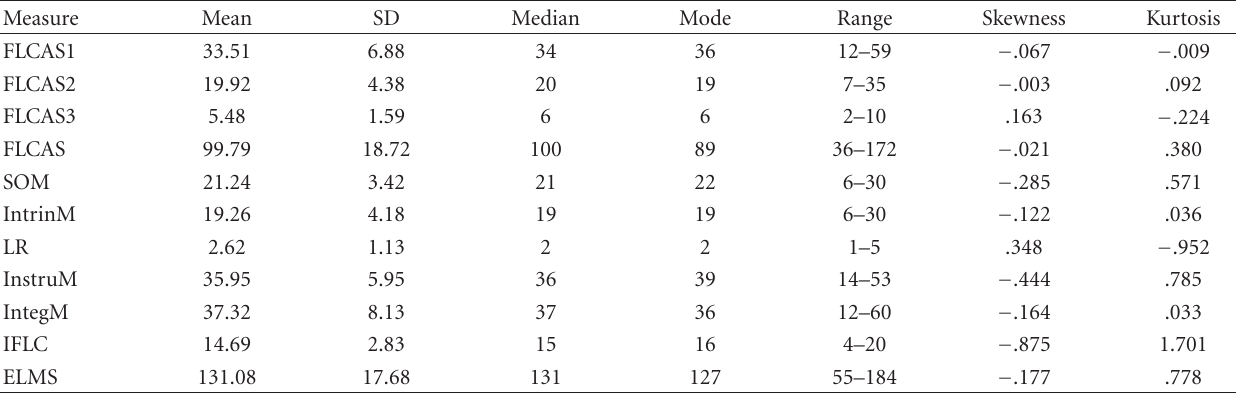
Table 2: Statistical analyses of the measured scales ( N =